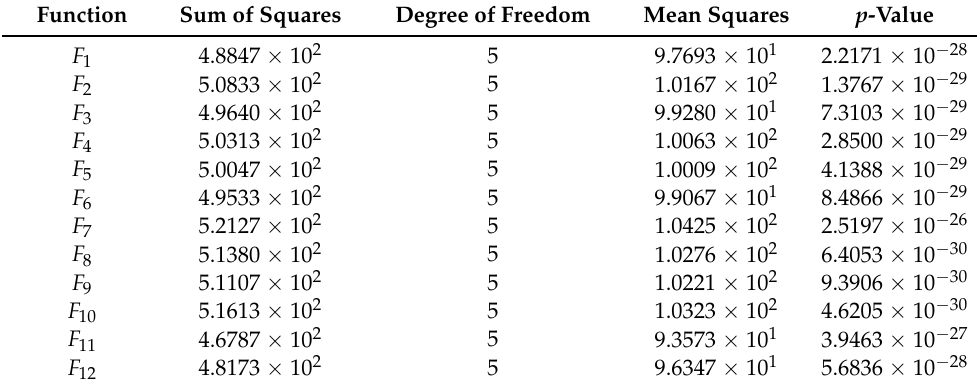
Table 3. Table 3. Friedman